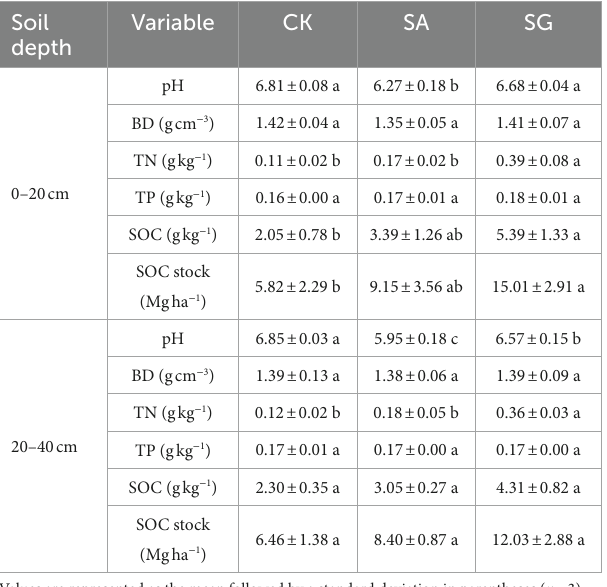
TABLE 1 Effects of different restoration modes on soil physiochemical properties in different soil